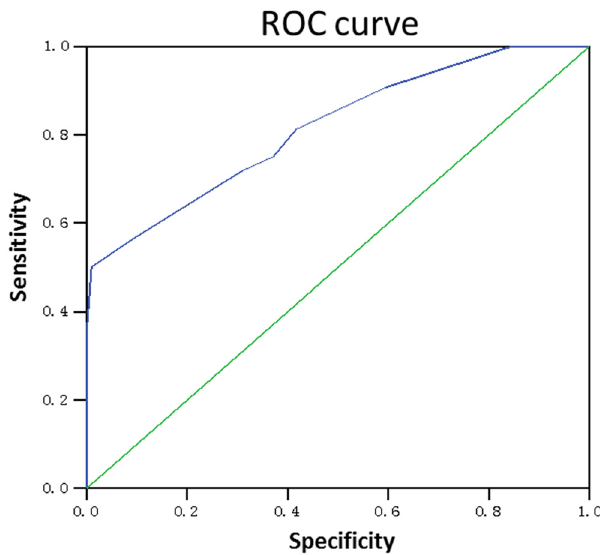
Fig 1. ROC curve analysis of the Chinese version of the HFRM in predicting falls in Chinese elderly inpatients.